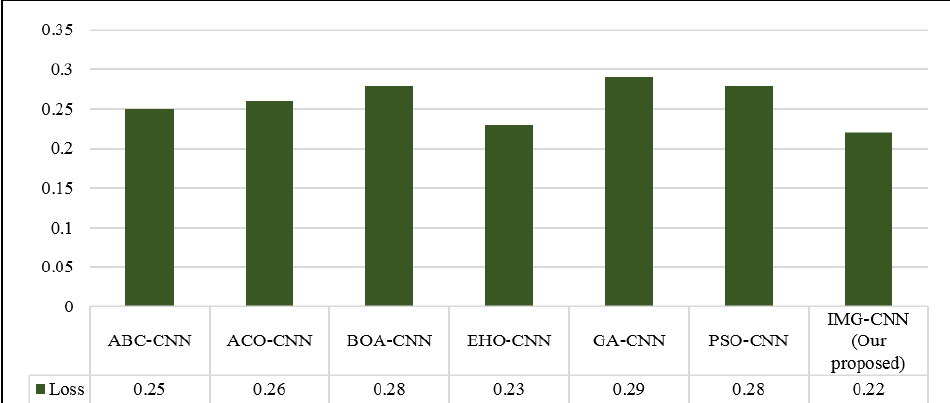
Figure 17. Loss comparison among the different models presented in previous studies and our proposed IMG-CNN model using deep learning